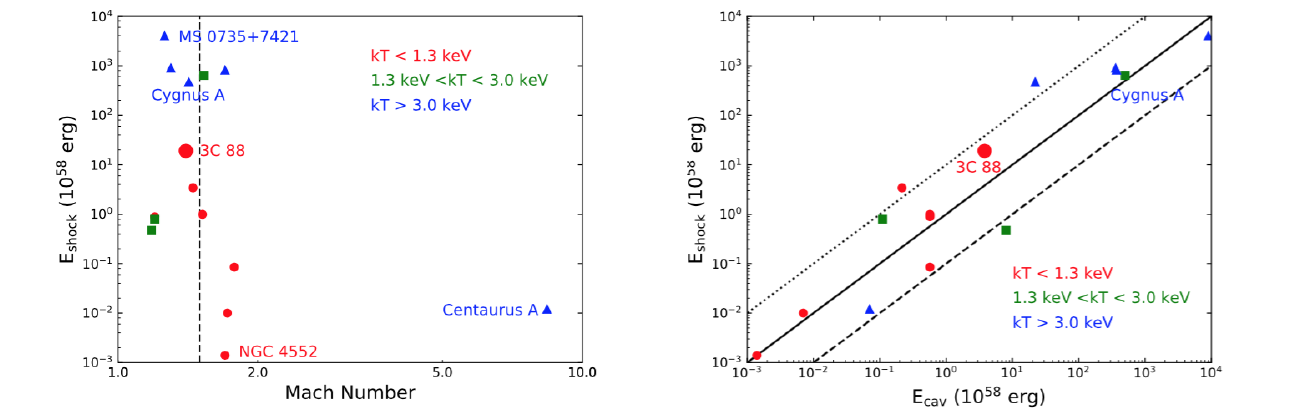
Figure 4. Shock energy versus Mach number ( left panel ) and shock energy versus cavity enthalpy ( right panel ) for groups and clusters with available shock energy in the literature. Figure reproduced from Liu et al. [115]. Objects with a red circle have kT < 1.3 keV, green square: 1.3 < kT < 3.0 keV and blue triangles kT > 3.0 keV. The dashed line in the left panel marks M = 1.5 and the dotted, solid, dashed lines in the right panel represent E shock / E cav =10, 1, 0.1 respectively. The objects considered in the plots are: Hydra A [101,119], MS 0735+7421 [102], Centaurus A [120], Cygnus A [92,121], 3C 444 [122], M87 [118], Abell 2052 [123], 3C 310 [124], NGC 4552 [117], NGC 4636 [125], HCG 62 [126], and NGC 5813